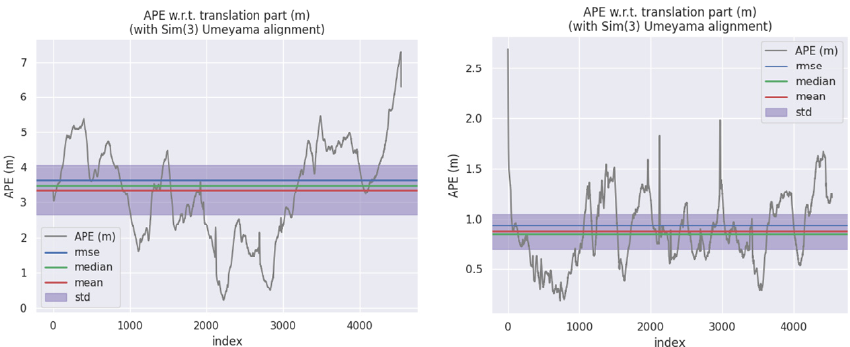
Figure 6. The comparison in APE of two algorithms in the KITTI dataset.